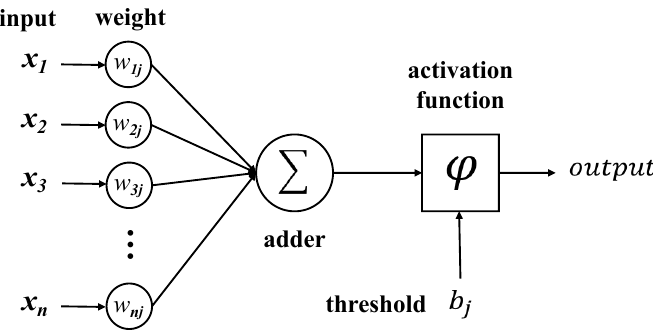
Figure 4. The basic structure of a neuron.